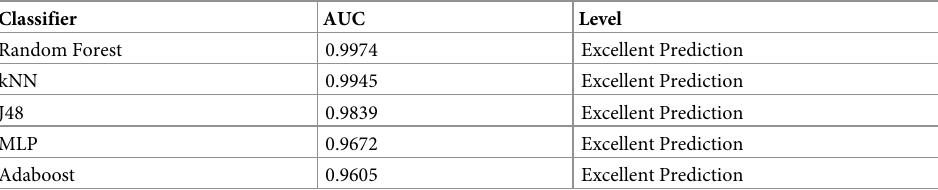
Table 10. Evaluation of